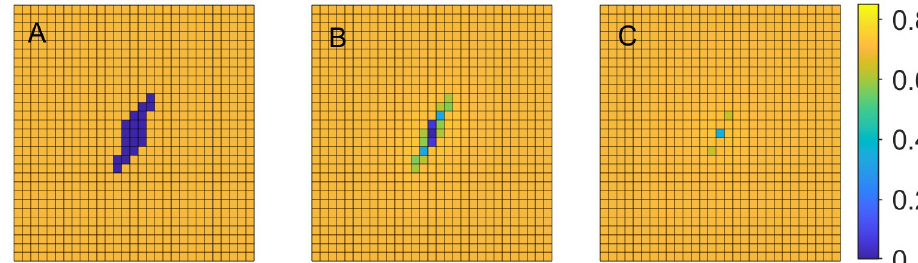
Fig 1. Tissue regeneration. Cellular volume fraction u 1 at various time steps with b 1,max = 0.03. A: time step t = 1, B: time step t = 11, C: time step t = 21.